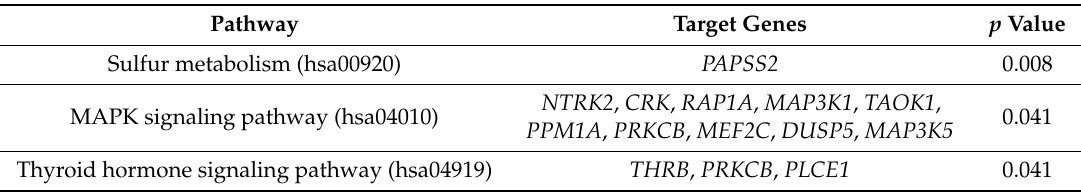
Table 3. Pathway analysis of target genes for miR-203a-3p, which was expressed higher in the low-OHRQoL group than in the high-OHRQoL group. Pathway Target Genes p Value Sulfur metabolism